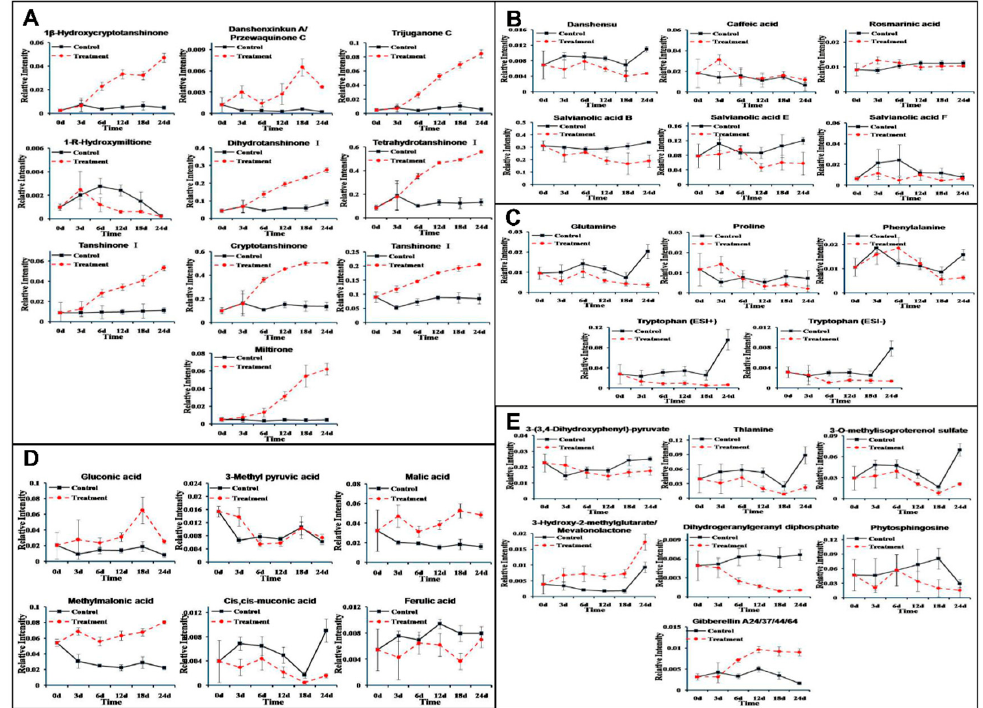
Figure 5. The relative quantification of the identified differential metabolites ( A ) tanshinones; ( B ) phenolic acids; ( C ) amino acids; ( D ) organic acids; and ( E ) other compounds, between the control (black solid lines) and PSF-treated (red dotted lines) S. miltiorrhiza hairy roots at different time points post-elicitation.